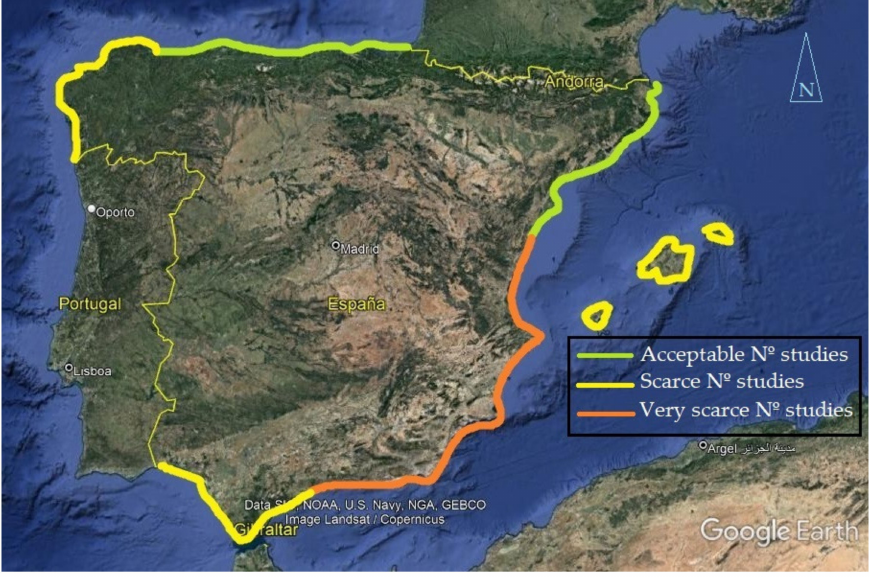
Figure 1. Number of studies in Spain. Taken from